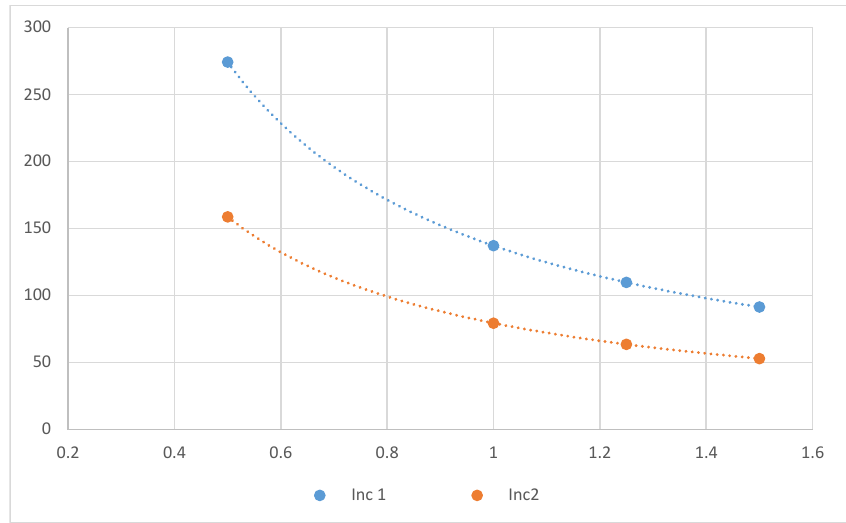
Figure 7. Better fit mathematical functions for values of STPC (short-term peak concentration) ( μ g/m 3 ) for formaldehyde at different ventilation rates (h − 1 ) for Inc 1 and Inc 2.